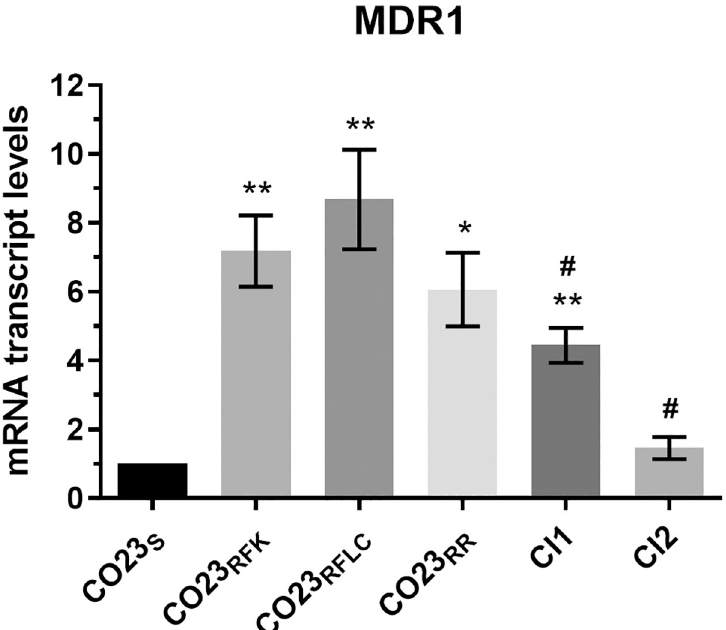
Fig 3. Expression levels of C . albicans MDR1 gene determined by real-time PCR. The expression level of the MDR1 gene in the wild-type (CO23), resistant (CO23RFK, CO23RFLC and CO23RR) strains and Clinical Isolates (CI1 and CI2) are represented as n-fold increase or decrease relative to the level of the control strain (CO23). Data are shown as mean ± SEM from three independent experiments performed in triplicate. � p < 0,05, �� p < 0,01, ��� p < 0.001, ���� p < 0,0001 vs CO23 S and # p < 0.05, ## p < 0,01, ### p < 0.001, #### p < 0,0001 vs CO23 RR .